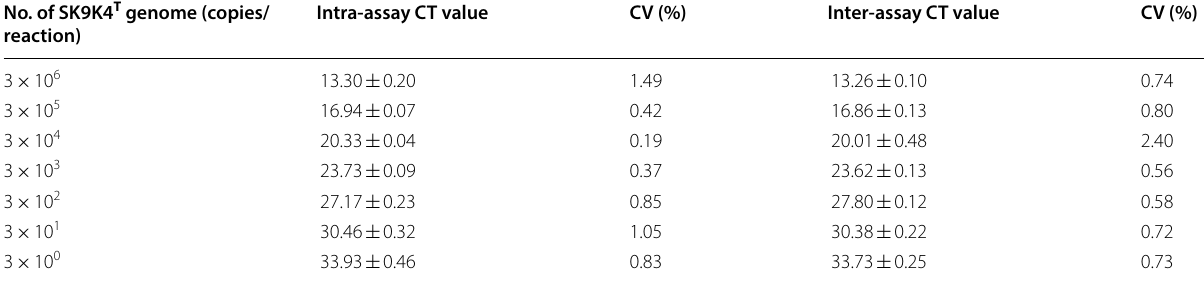
Table 2 Reproducibility, intra-assay, and inter-assay coefficient of variation for TaqMan qPCR No. of SK9K4 T genome (copies/ reaction)